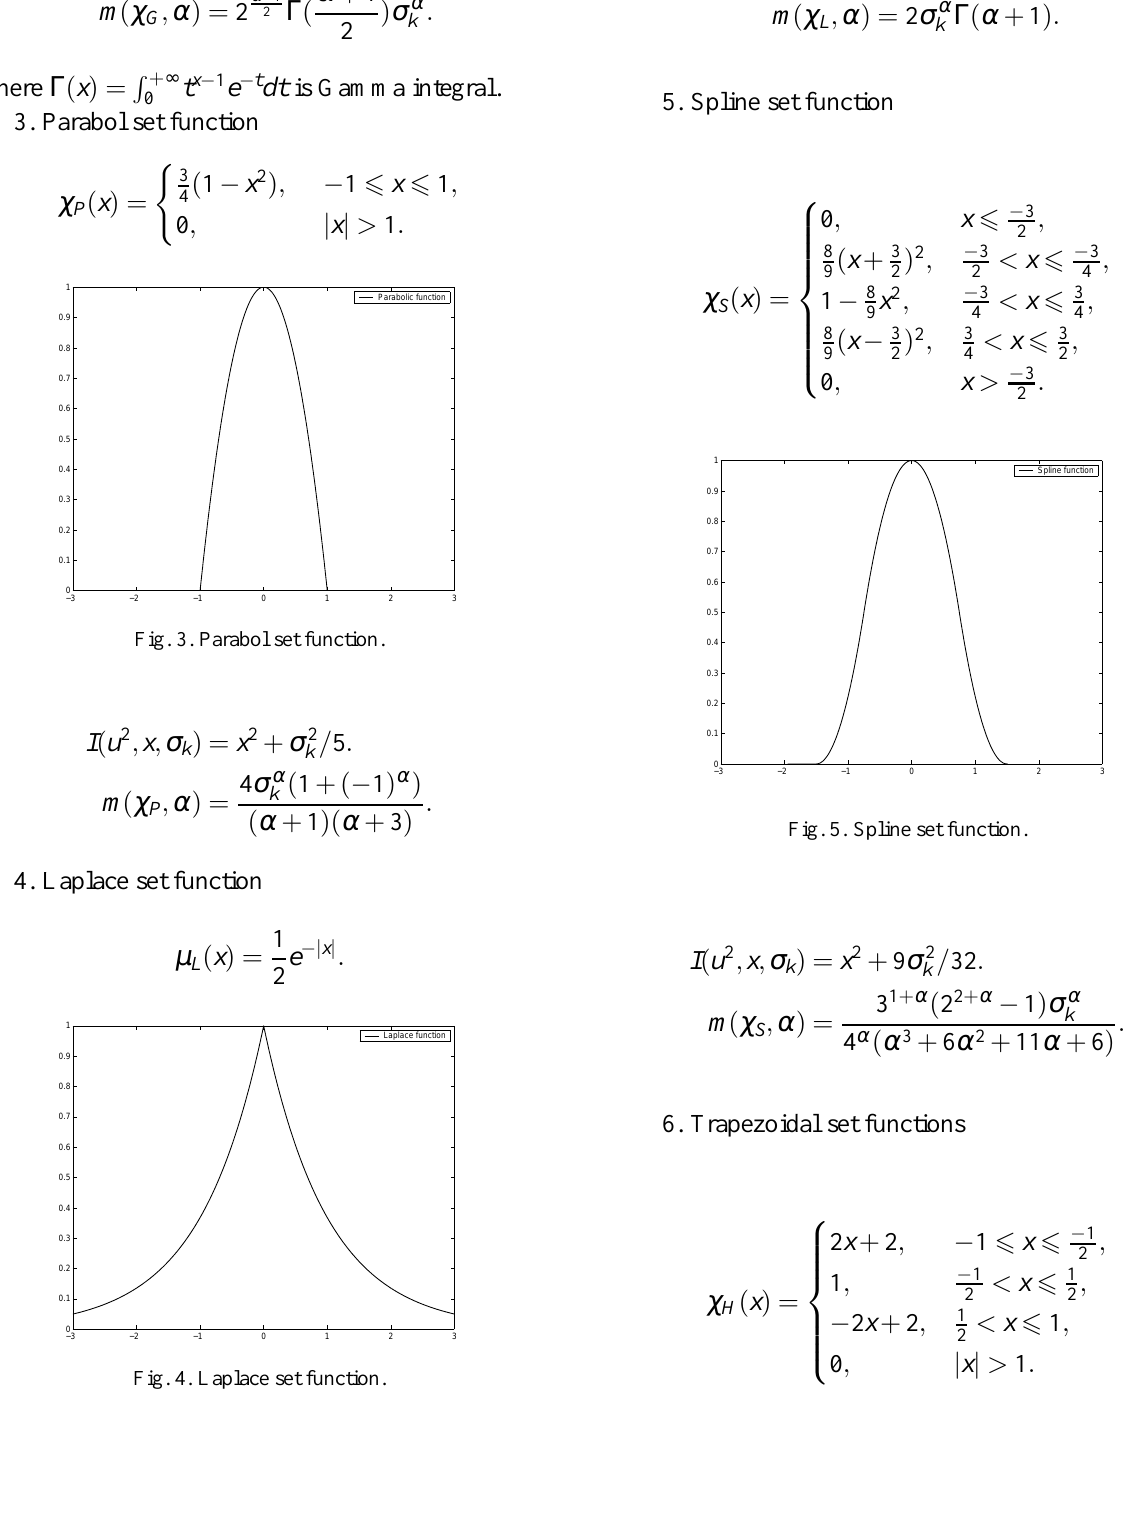
Fig. 4. Laplace set function.